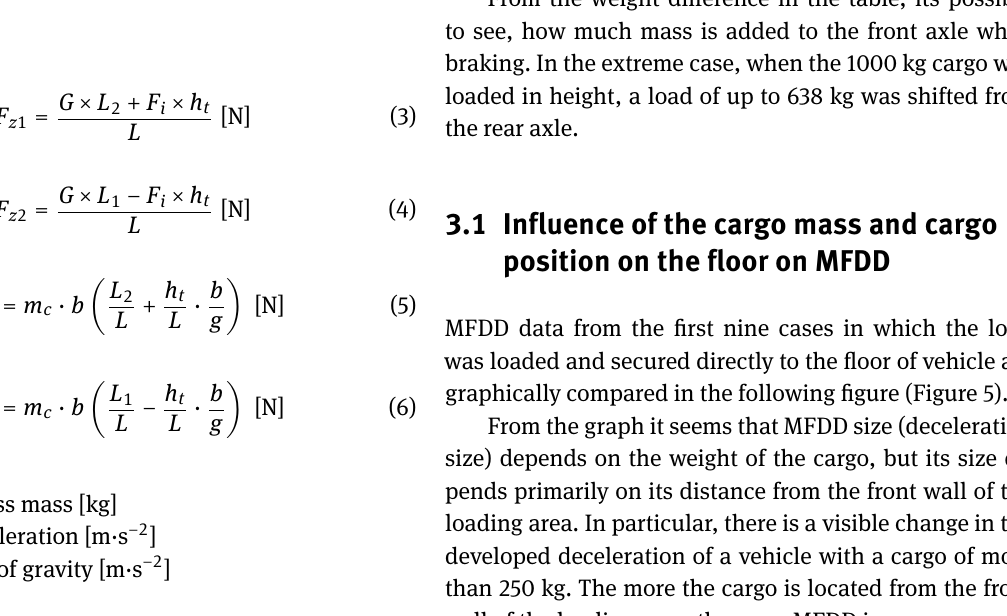
Figure 2: The forces applied to the braked vehicle. Source: